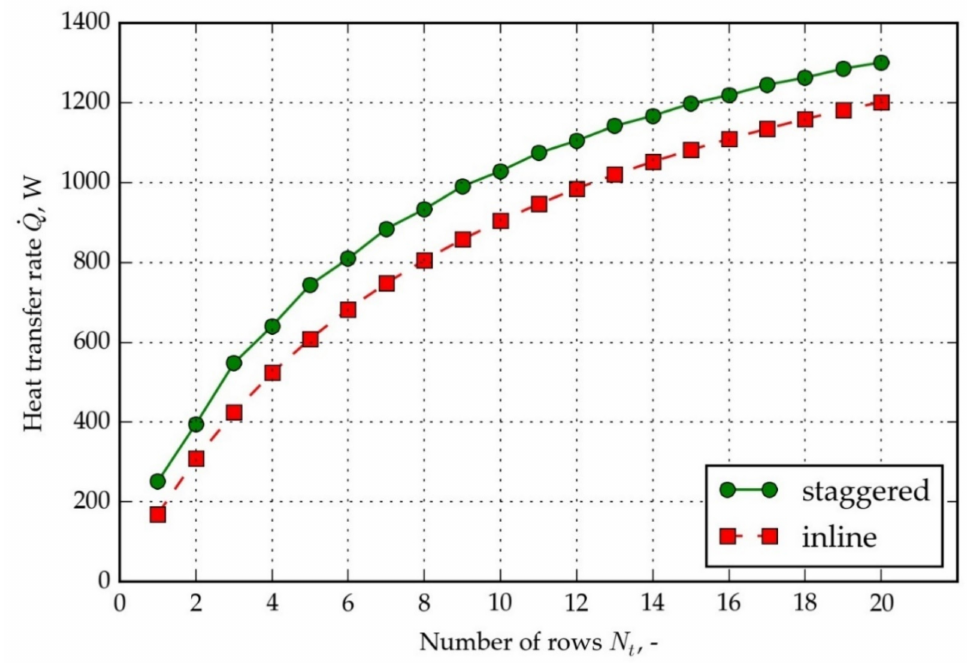
Figure 8. Heat transfer rate for inline vs. staggered heat pipe arrangement, for inlet cold air temperature 10 ◦ C and hot air inlet temperature 30 ◦ C.